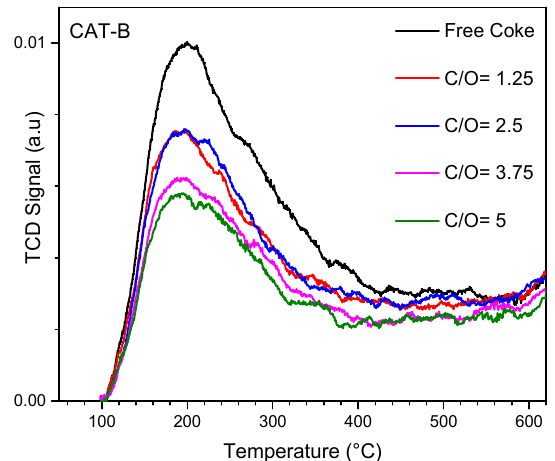
Figure 2. NH 3 -TPD analyses for CAT-B. Notes: Continuous black line: FCC catalyst free of coke; continuous red line: C/O = 1.25; continuous blue line: C/O = 2.5; continuous violet line: C/O = 3.75; continuous green line: C/O = 5; continuous blue line: experiment baseline. Samples with coke were analyzed following catalytic cracking runs at 550 °C and 7 s.